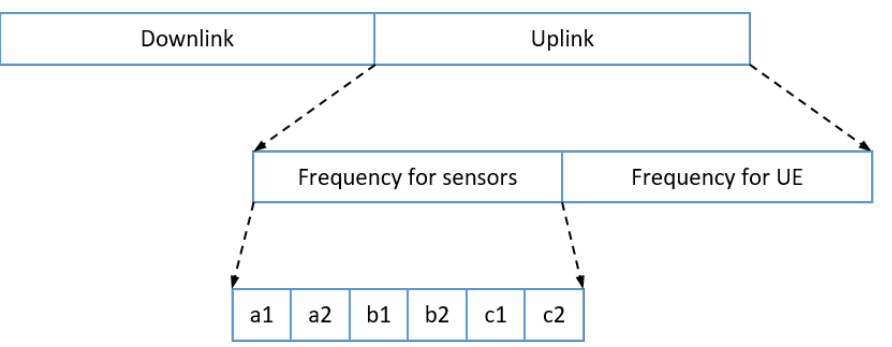
Figure 3. The cell structure in FFR-3.